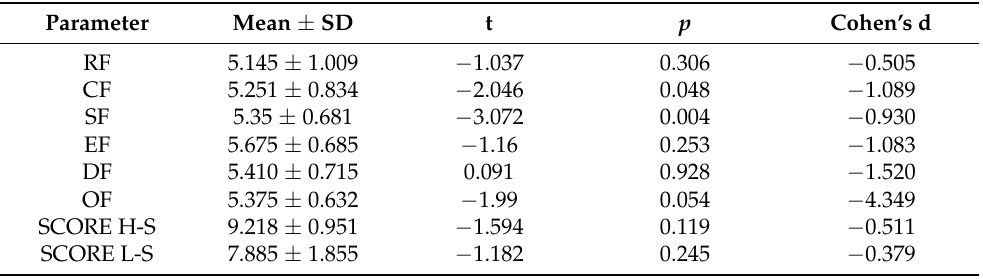
Table 2. Averages and standard deviations of the responses to the questionnaire for all participants. Parameter Mean ± SD t p Cohen’s d RF 5.145 ±